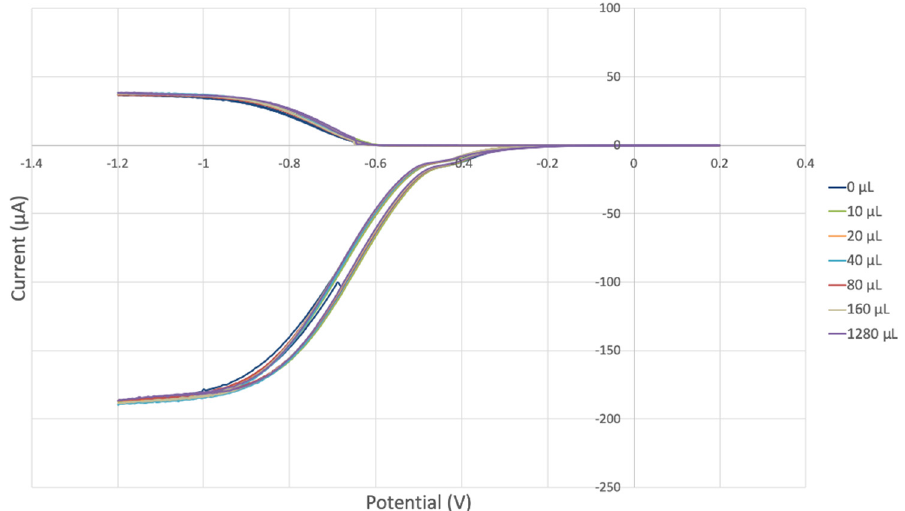
Figure 14. THQ is not able to scavenge superoxide, as no variation is found with increasing concen ‐ tration of